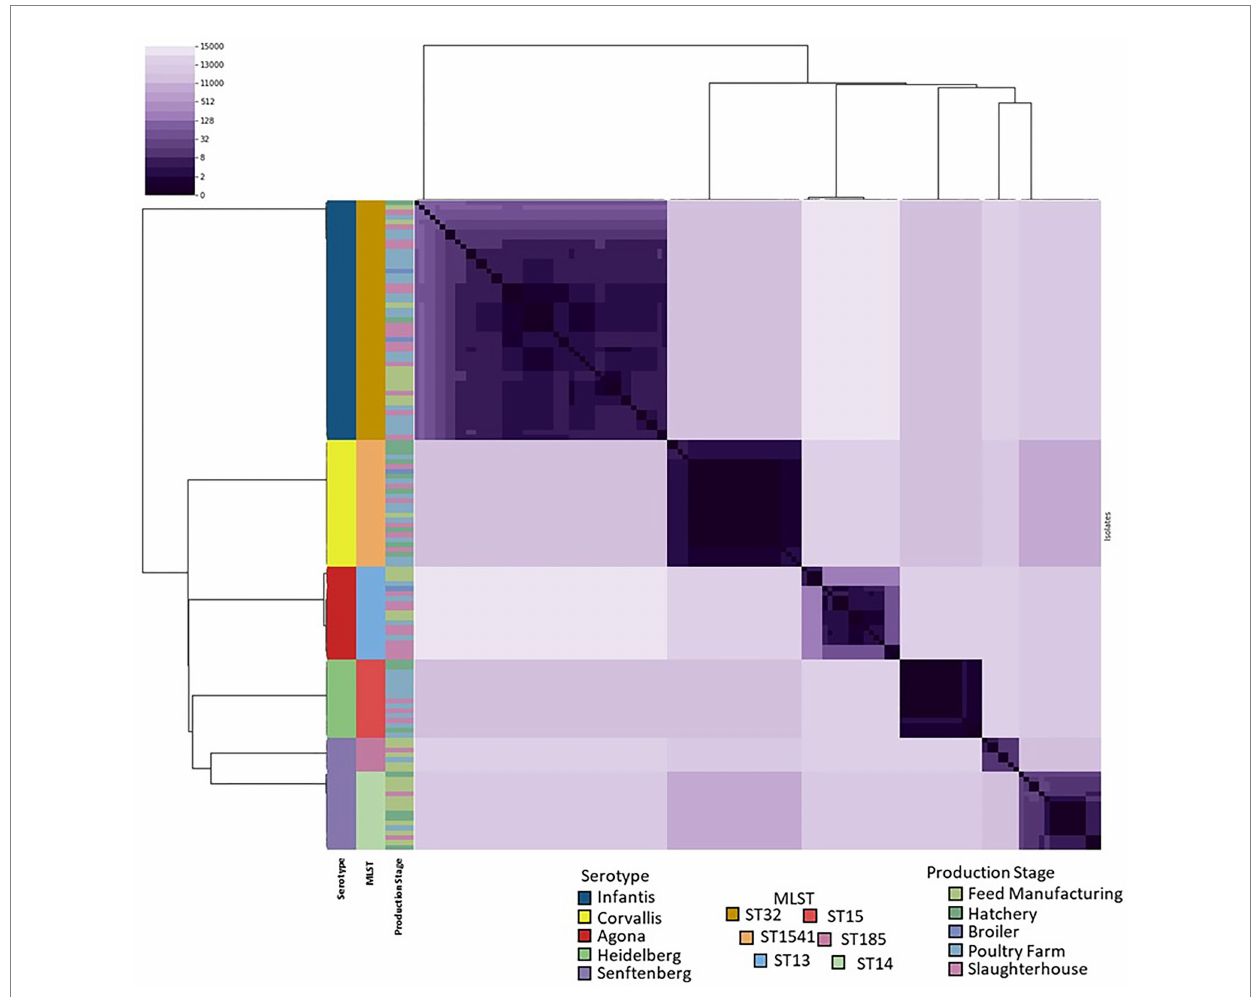
FIGURE 2 Heatmap of pairwise SNP distances of the 133 genomes. The dendrogram corresponds to the hierarchical clustering of the SNP distance matrix data. The colors on the left correspond to the serotype, genome typing and origin of the isolate within the production